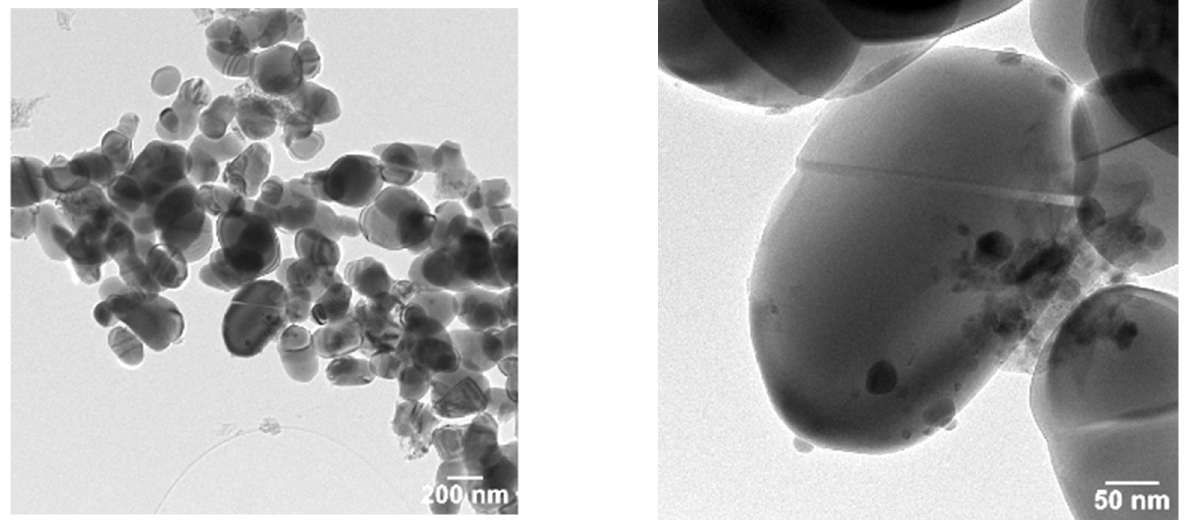
Figure 2. TEM images of the S2 (Ca-Cu/TiO 2 ) sample. Electron diffraction in a selected area (SAED) demonstrated the crystalline nature of the rutile TiO 2 microparticles. The elementary distributions of Ca and Cu on the TiO 2 microparticles were highlighted by the elementary mappings obtained in scanning transmission electron microscopy (STEM) mode (Figure 3).